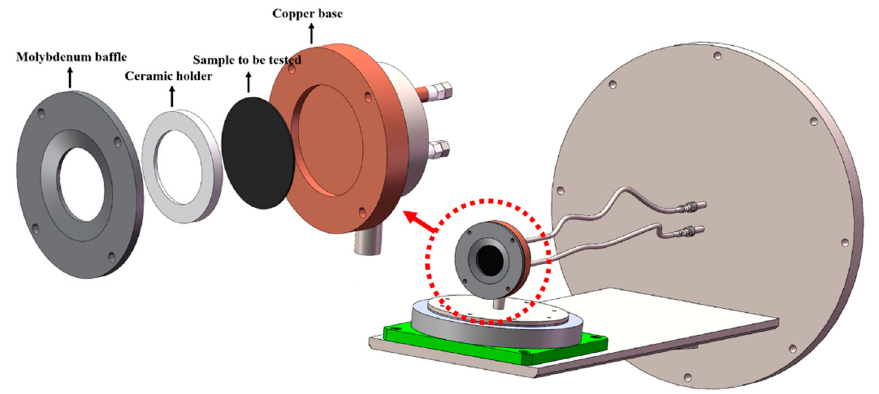
Figure 13. Schematic drawing of the rotatable angle target system and the facing plasma part. Sensors are installed between the molybdenum baffle and the sample to measure the temperature of the sample. The inlet and outlet water-cooling pipes are also with thermometers and flow meters, and the combination of the two can give the heat load density. The entire target part can be rotated to realize material testing with different incident angles.